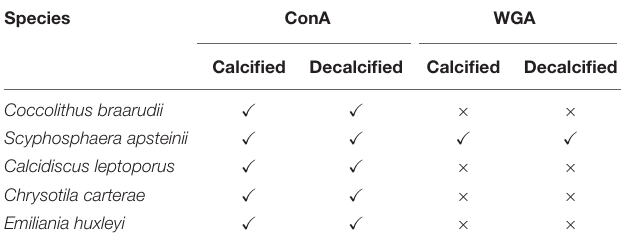
TABLE 1 | Results of polysaccharide lectin staining in coccolithophores. Species ConA WGA Calcified Decalcified Calcified